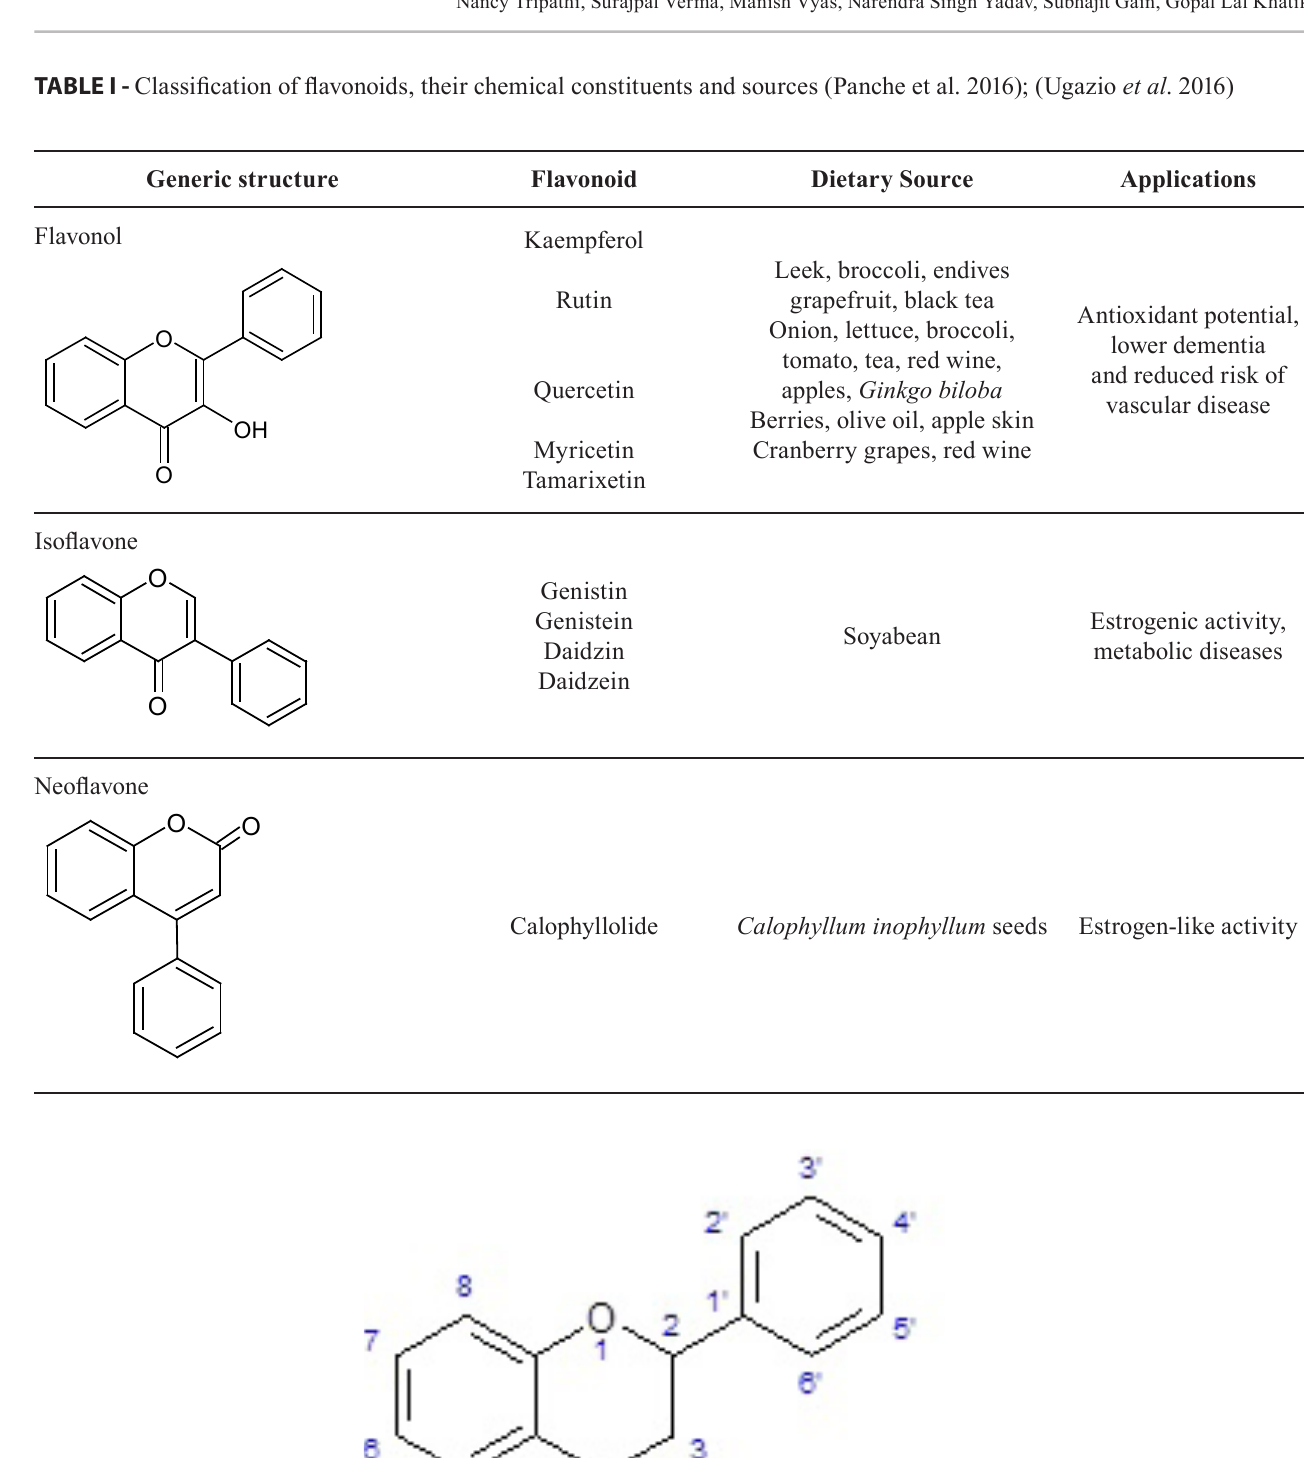
TABLE I - Classification of flavonoids, their chemical constituents and sources (Panche et al. 2016); (Ugazio et al . 2016)